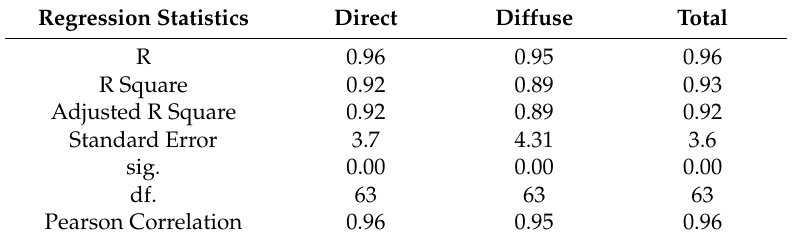
Table 1. Correlation between crown openness and solar radiation derived from Hemispherical Photography (HP).